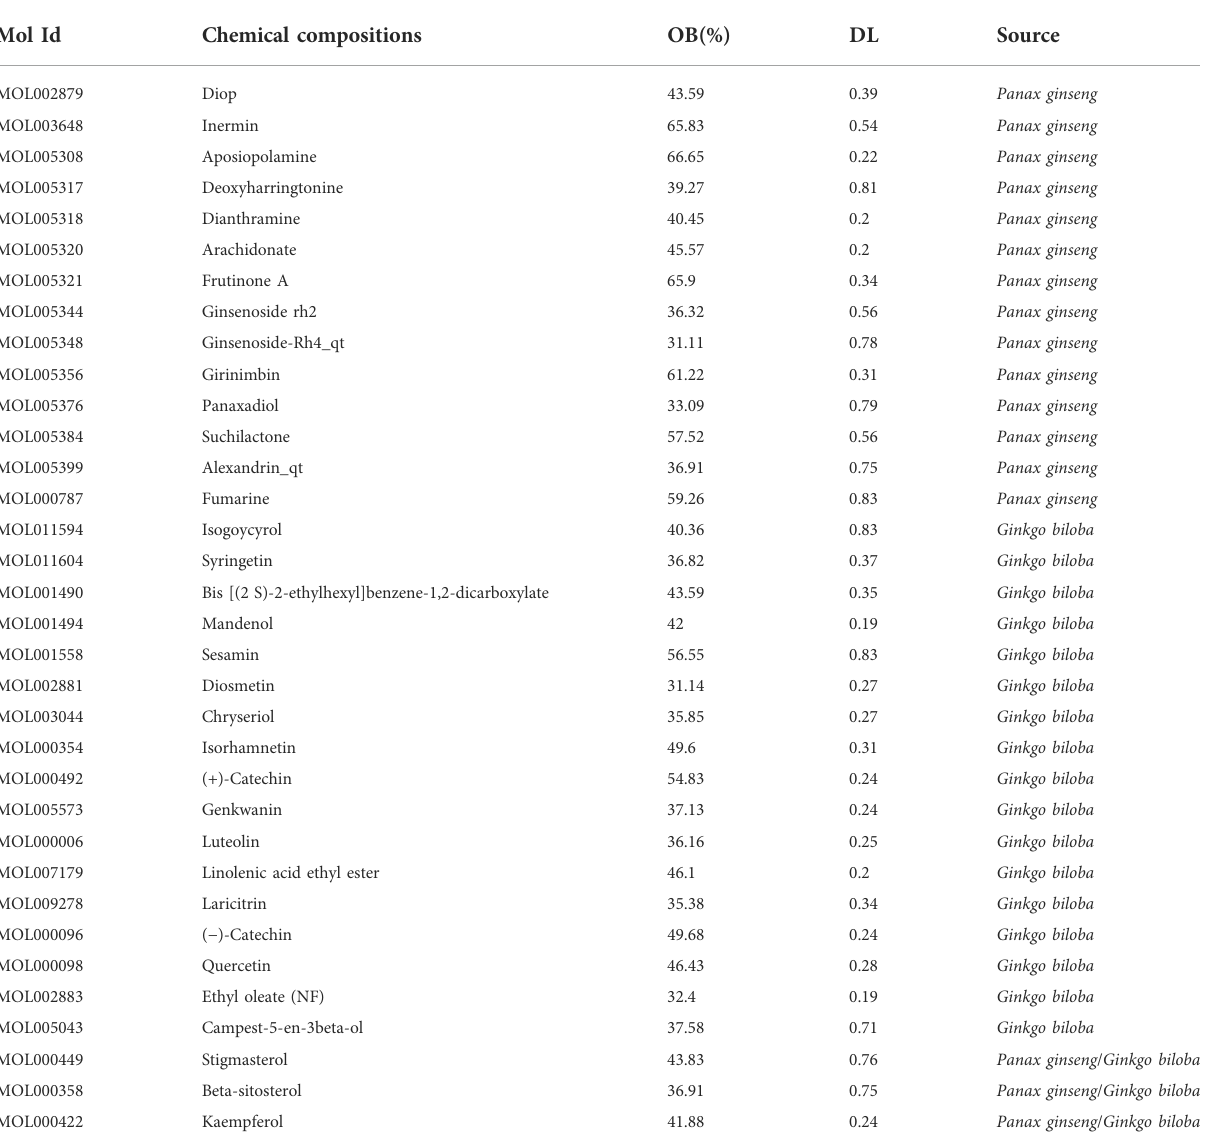
TABLE 1 The chemical compositions of CGGE. Mol Id Chemical